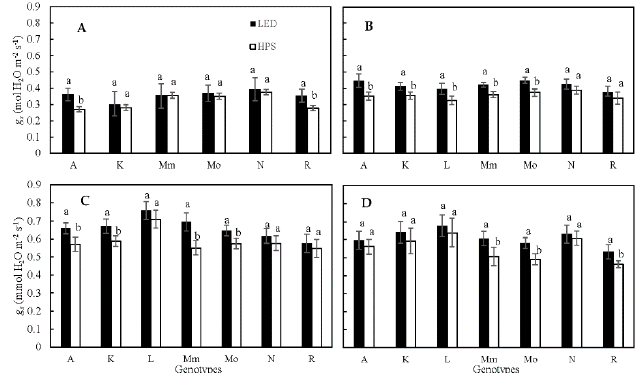
Figure 1. Stomatal conductance ( g s ) per genotype grown under HPS and LED supplemental light (measured using porometer), during Expt. 1–4 ( A – D ). Values are the average of measurements from 3 plants per genotype. Different letters above bars within a panel and for each genotype separately indicate significant differences according to Fisher’s protected LSD test ( p = 0.05). Error bars show ± SD. A—Ailsa Craig; K—Kentucky Beefsteak; L—LA1578; Mm—Moneymaker; Mo—Momotaro; N—Nunhems-FM00; R—Rutgers.